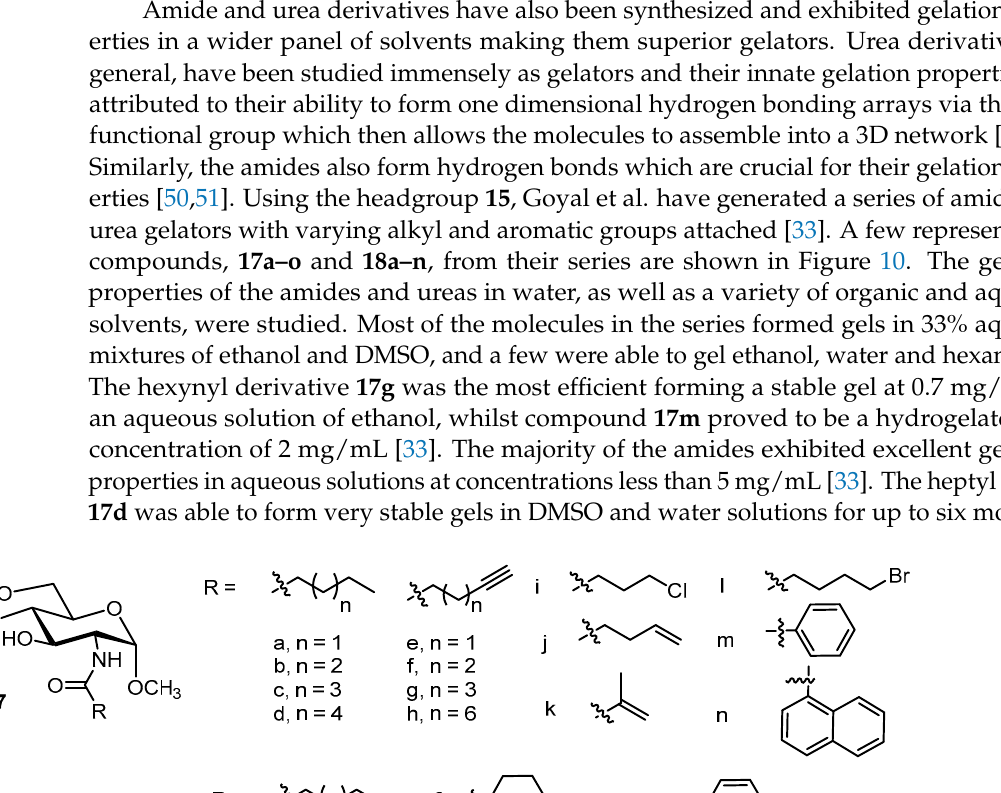
Figure 9. Structures of carbamate derivatives of 4,6-O-benzylidene-methyl-a-D-glucosamine [34].